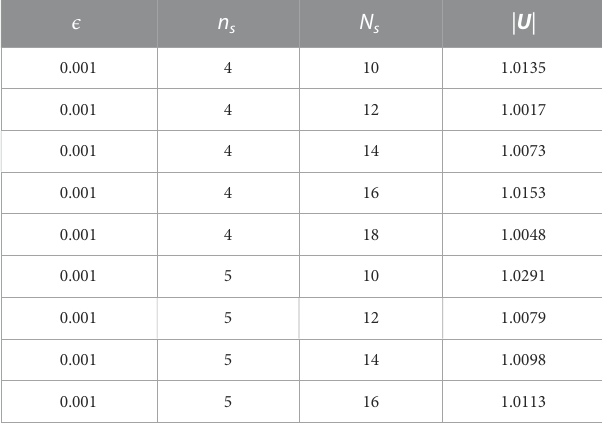
TABLE 1 Predictions for the free space swimmer speed. The exact speed is given by | U | = 1 and its numerical calculation is presented for re fi nements of both the discretisations used in the nearest – neighbour regularised Stokeslet method, where N (cid:1) 6n 2 s and Q (cid:1) 6 N 2 s